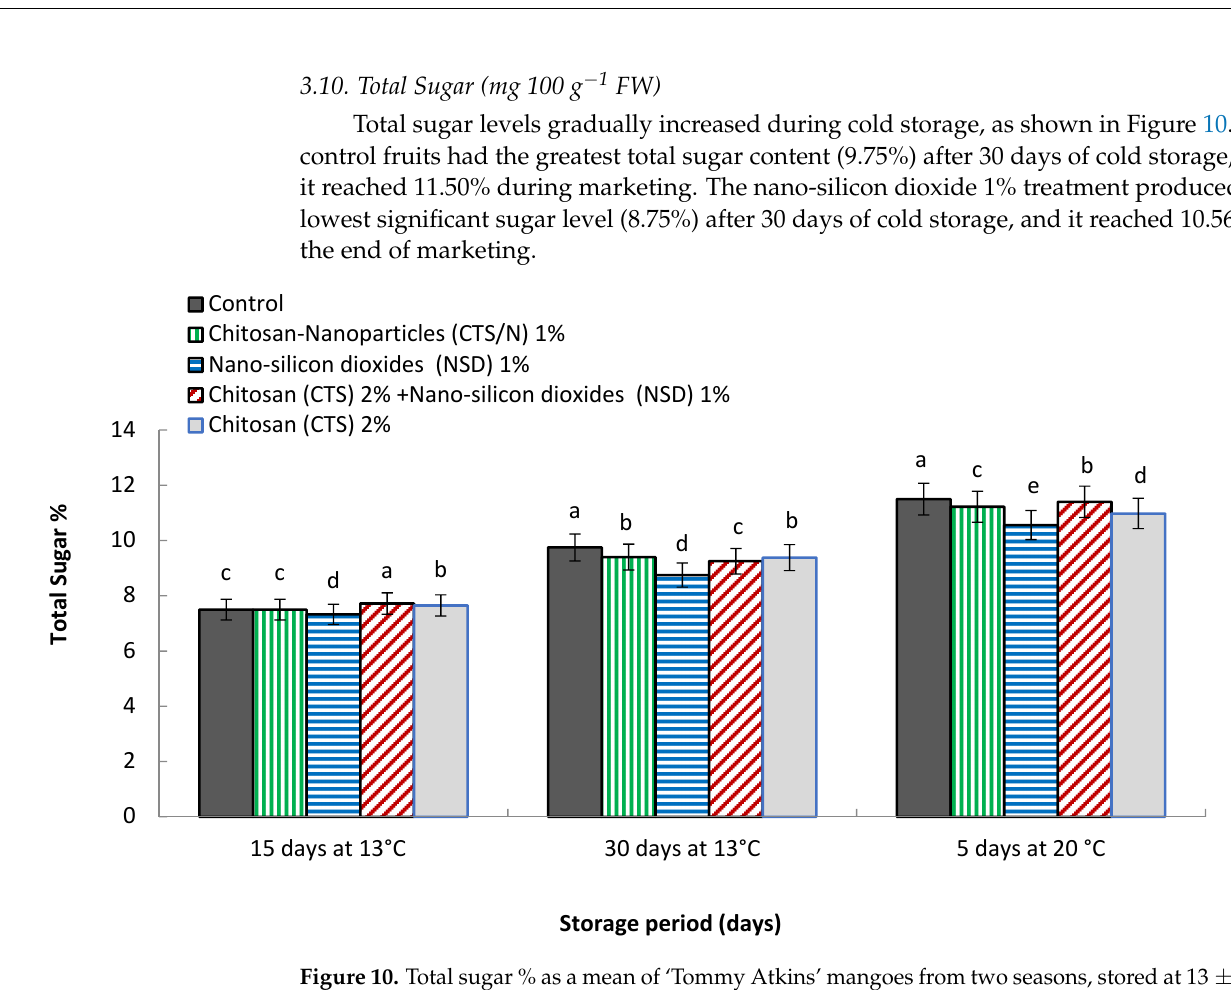
Figure 10. Total sugar % as a mean of ‘Tommy Atkins’ mangoes from two seasons, stored at 13 ± 1 °C and 90–95% RH for 30 days. Afterward, the fruits were stored at 20 ± 2 °C and 70–75% RH for 5 days as the marketing period. Vertical bars indicate the standard error (SE) of the mean ( n = 5). The superscript letters followed by the same letters are not significantly different according to Duncan’s multiple range test at 0.05 level.